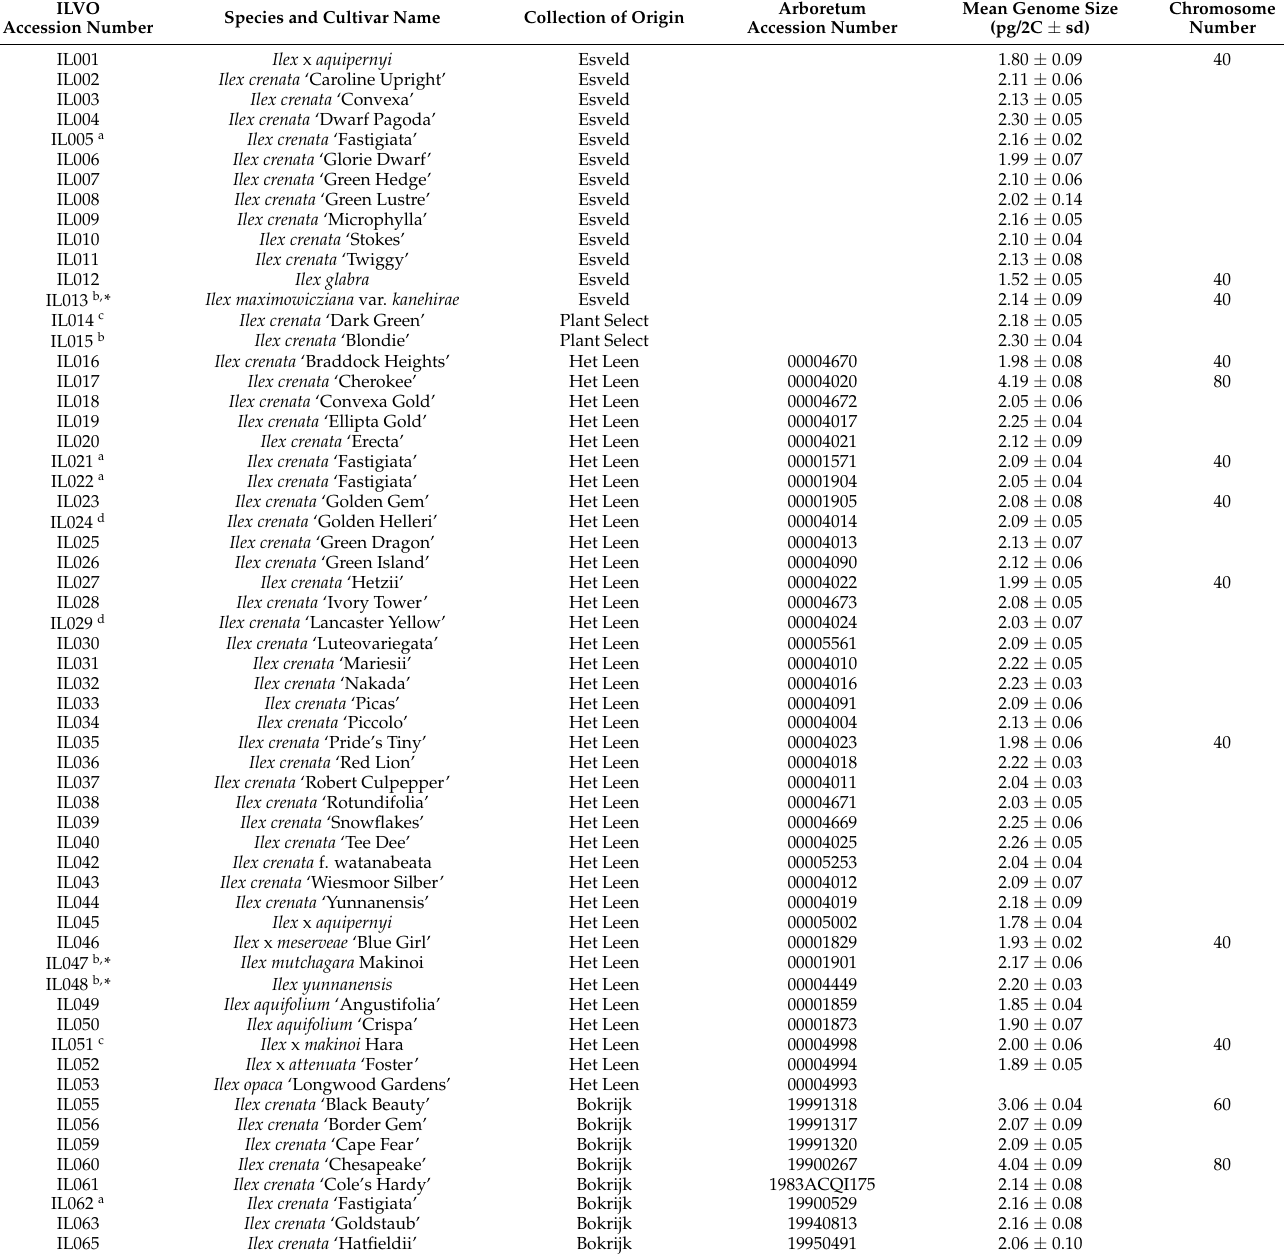
‘Fastigiata’ was sampled multiple times from independent sources. Thirteen accessions were purchased as potted plants from Esveld Plant Garden (The Netherlands), 78 geno- types were collected as cuttings from the arboreta of Bokrijk (Genk, Belgium) and Het Leen (Eeklo, Belgium), and 3 genotypes were obtained as potted plants from the company Plant Select. The plants were maintained as potted plants in a container field at ILVO (51 ◦ 00 (cid:48) N, 3 ◦ 78 (cid:48) E, Melle, Belgium) (Table 1). Table 1. Overview of the Ilex collection. The table shows all the accessions and for every genotype: the accession number used at ILVO; the species and cultivar name; the collection of origin, along with the accession number from the arboretum; the mean genome size; and the chromosome number. Genetically identical accessions are indicated with the same superscript letter (a–d), accessions for which a naming problem was discovered are indicated with an